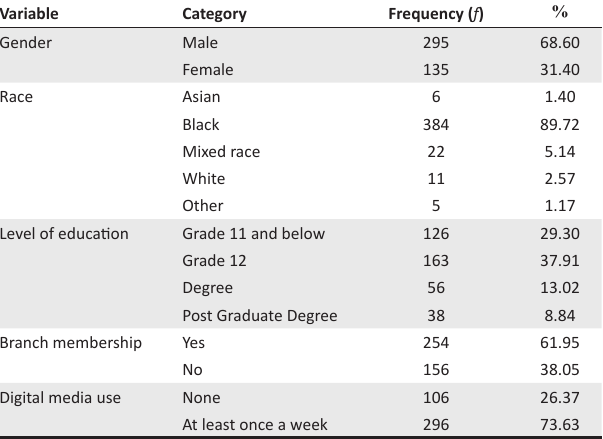
TABLE 1: Respondents’ biographic information ( N =